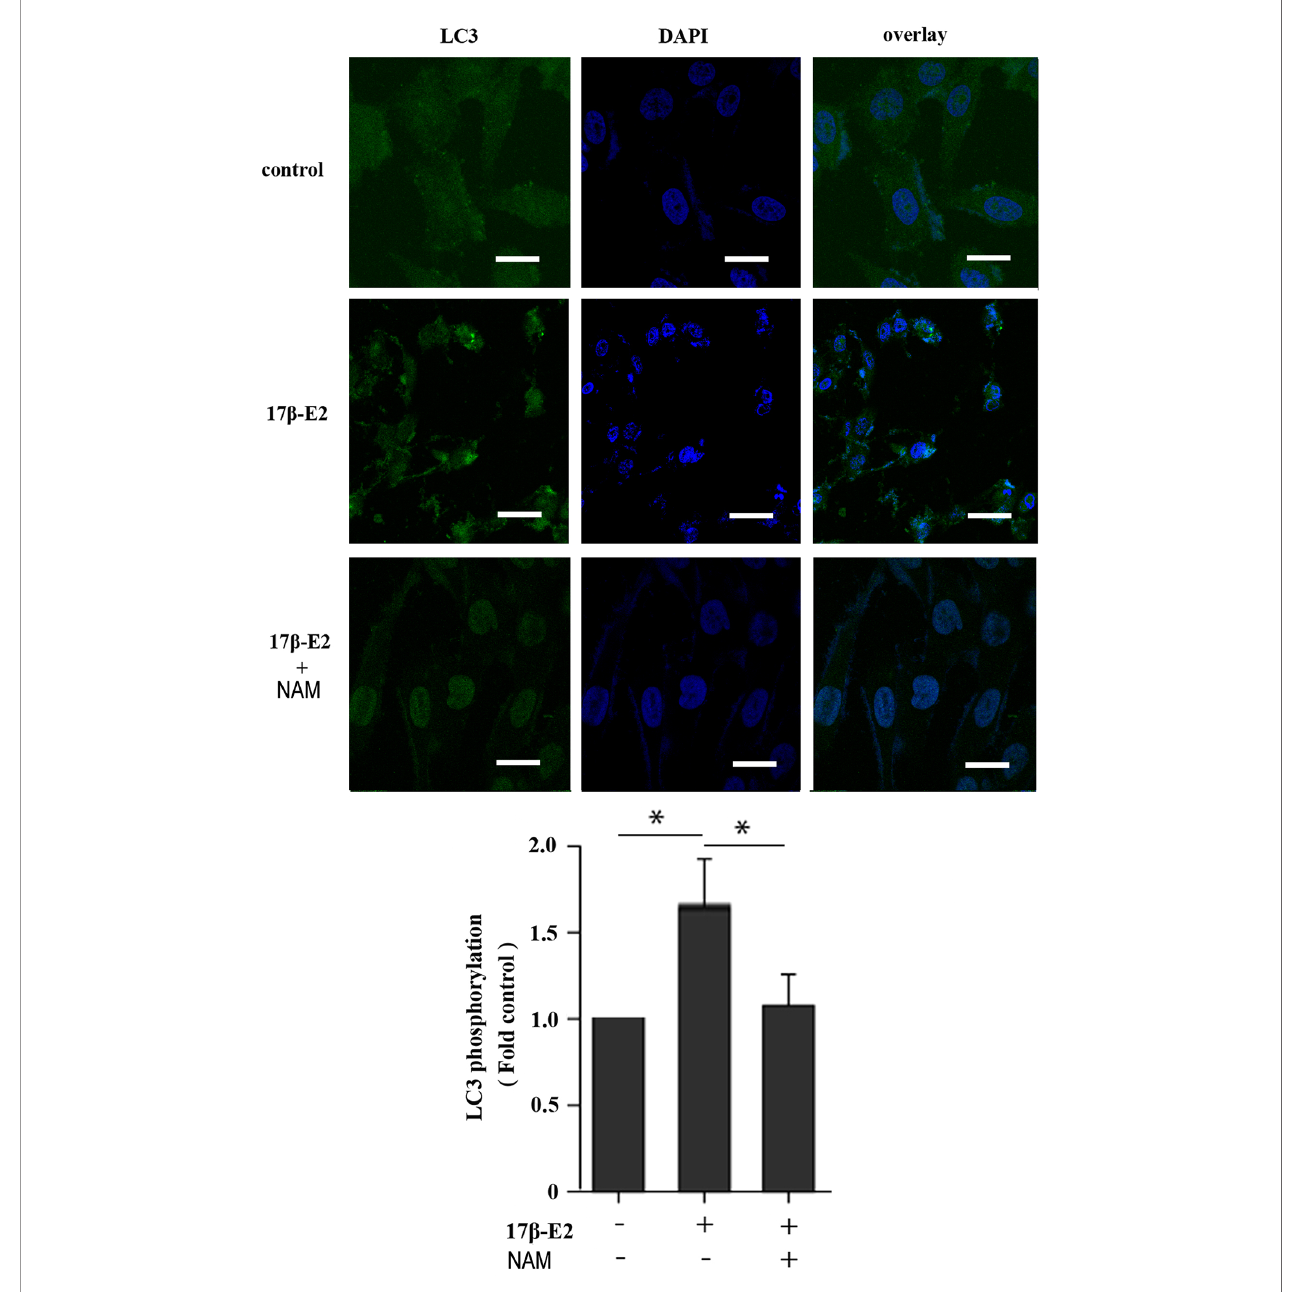
FIGURE 4 | Effect of 17 b -E2 and SIRT1 on expression of LC3 in ATDC5 chondrocytes. Confocal microscopy was performed to evaluate autophagy in chondrocytes pre-treated with 17 b -E2 or NAM. Nucleus were stained with 4 ’ , 6-diamidino-2-phenylindole (DAPI) (blue). Representative images of confocal immuno fl uorescence (IF) staining showing the LC3 in chondrocytes. White bar = 50 m m. * P < 0.05 versus the control group indicated a signi fi cant